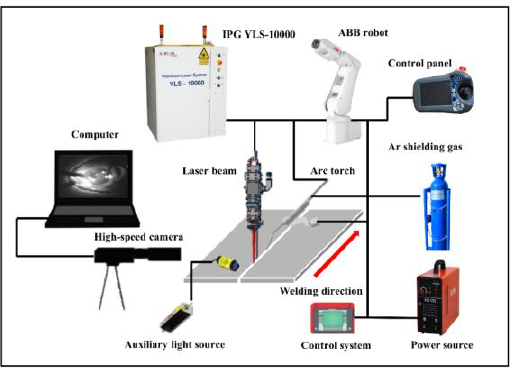
Figure 1. The schematic diagram of LAHW and observing droplet transfer behavior.